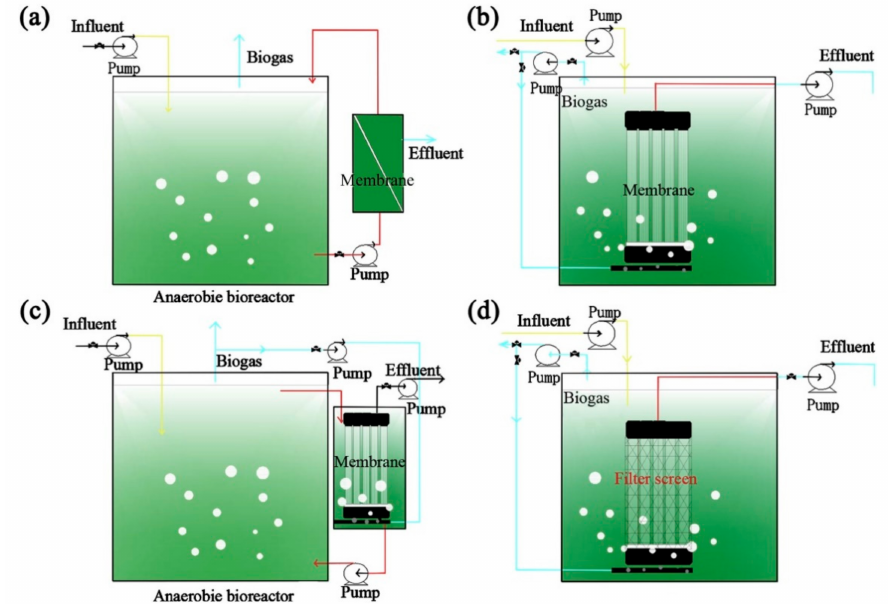
Figure 8. Conventional anaerobic membrane bioreactor (AnMBR) types. Side stream AnMBR ( a ), submerged AnMBR ( b ) and external submerged AnMBR ( c ). Novel AnMBR configurations: anaerobic dynamic membrane bioreactor ( d ). (Reproduced from [97] with Elsevier permission, license 4963301077334, 6 December 2020). Table 7. Efficiency of EPs removal in AnMBR system. Emerging